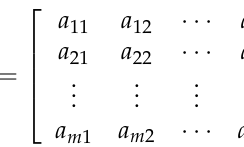
Figure 2. Flow chart of the DCA of target ships.